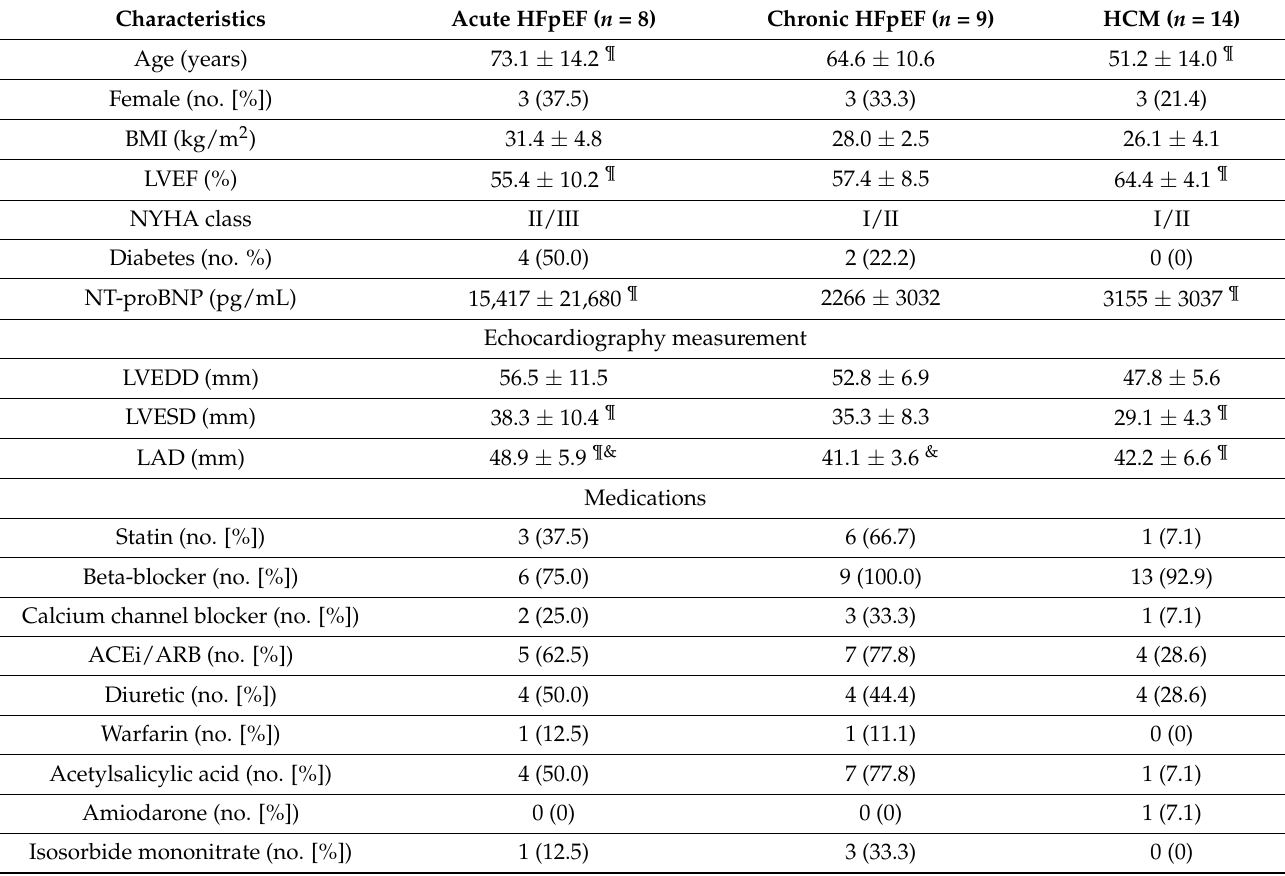
Table 1. Summary of patient